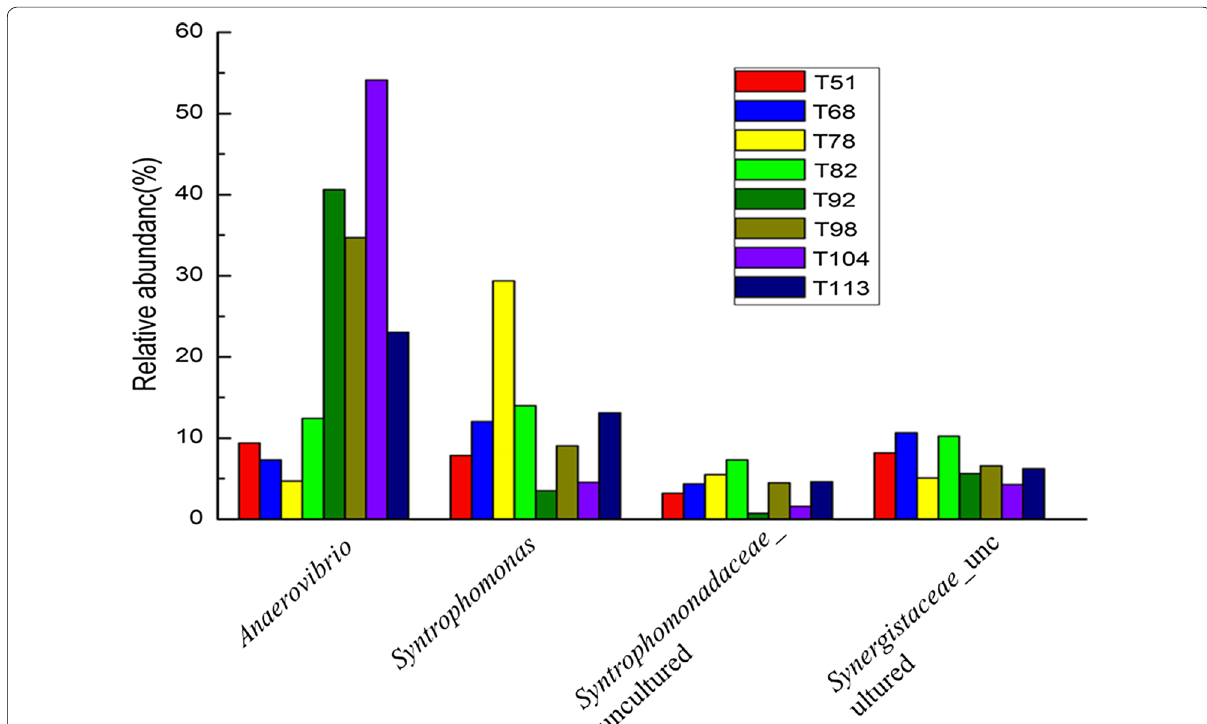
Fig. 6 Relative abundance of the lipolytic bacteria and three mainly syntrophy bacteria at the time of 51st, 68th, 78th, 82nd, 92nd, 98th, 104th and 113th